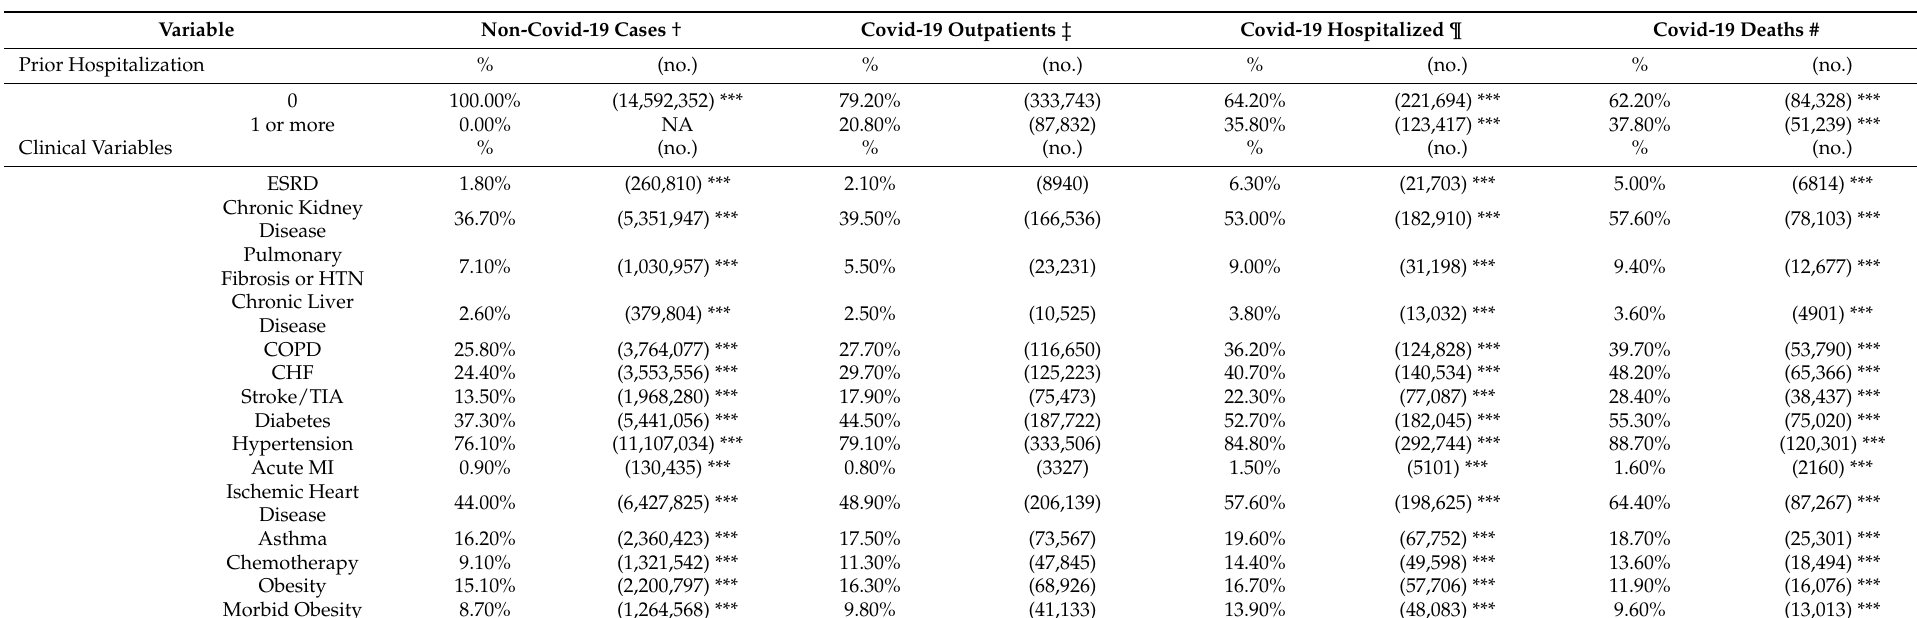
Table 1. Demographic, Clinical and Socioeconomic Characteristics of the Project Salus Medicare